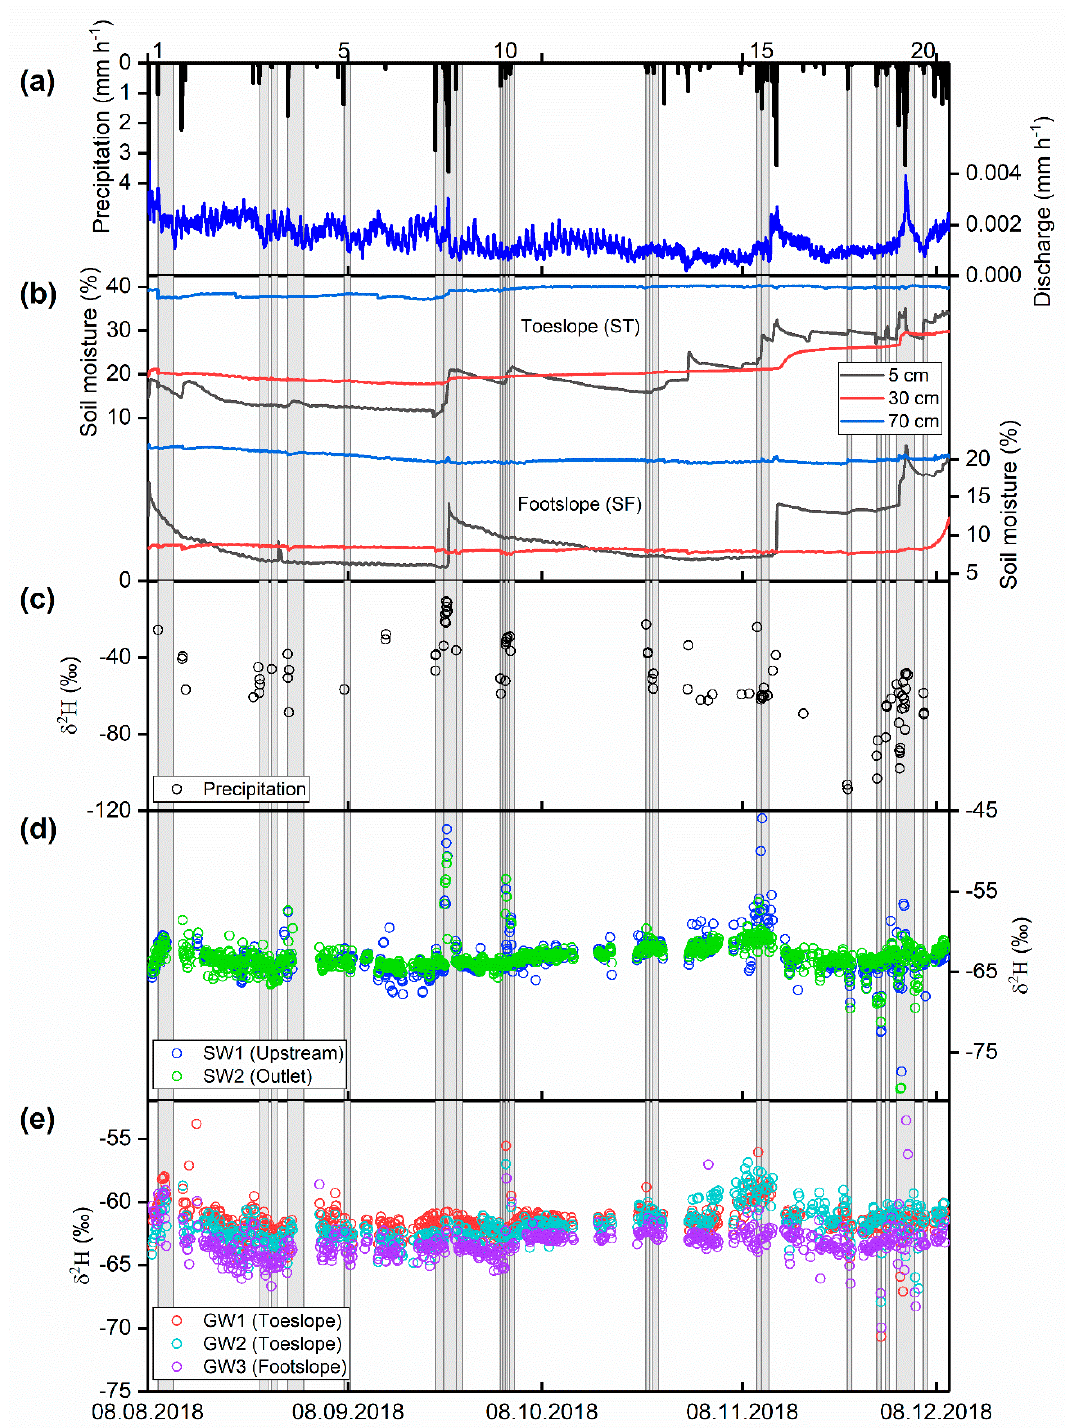
Figure 5. Time series of ( a ) precipitation and discharge, ( b ) soil moisture measured at 5, 30 and 70 cm depths at the toeslope and footslope, ( c ) δ 2 H in precipitation, ( d ) δ 2 H in stream water sources and ( e ) δ 2 H in groundwater water sources. The vertical grey bars indicate the 20 events. The numbers on top of panel ( a ) represent the event ID.